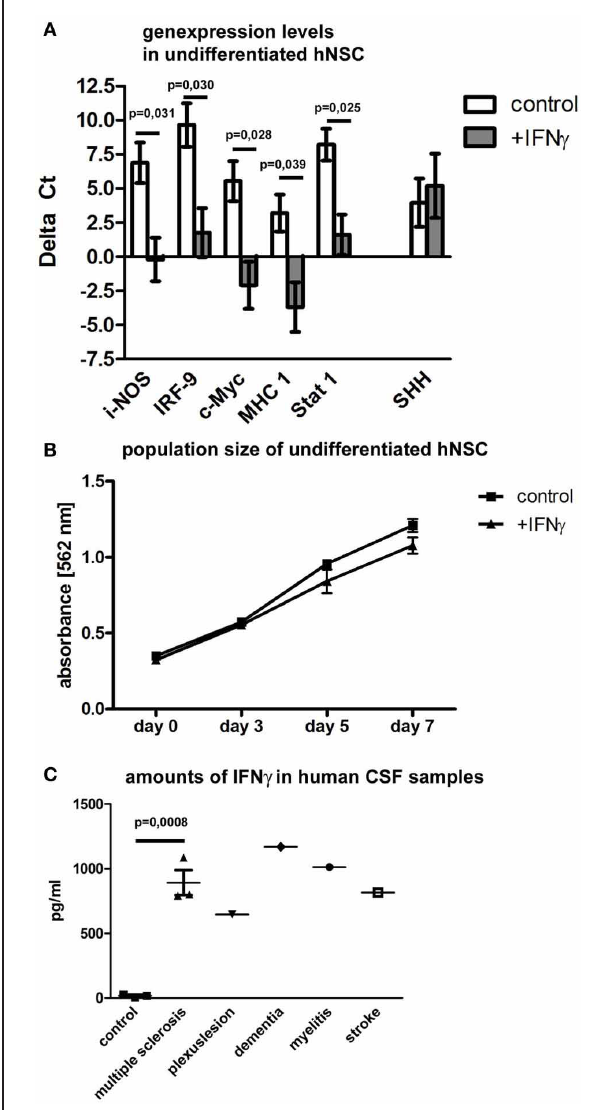
FIGURE 3 | Down-stream gene regulation and population size of hNSCs after IFN γ exposure and in vivo levels of IFN γ in patients CSF samples. In (A) gene expression levels in hNSCs (Wicell h9 line) of i-NOS (inducible nitric oxid synthase), IRF-9 (interferon regulatory factor 9), c-Myc, MHC1 (major histocompatibility complex 1), and Stat 1 (signal transducers and activators of transcription 1) are given either under control conditions or after IFN γ treatment. Results show that IFN γ significantly up-regulates important down-stream factors except of SHH. Values are means ± standard error of mean (SEM). Experiments were performed in triplicate and repeated independently at least three times. In (B) population size of hNSCs (Wicell h9 line) over 7 days is measured by means of an MTT-assay. Population sizes of two groups, hNSCs under control conditions or after IFN γ treatment, are compared. Results show that IFN γ does not affect the population size of hNSCs. Values are means ± standard error of mean (SEM). Experiments were performed in triplicate and repeated independently at least three times. In (C) amounts of IFN γ in clinical CSF samples are measured by ELISA in comparison to CSF samples of control patients. For statistical testing of the multiple sclerosis group, 3 control patients were compared with 3 multiple sclerosis patients [unpaired two-tailed t -test, value is mean ± standard error of mean